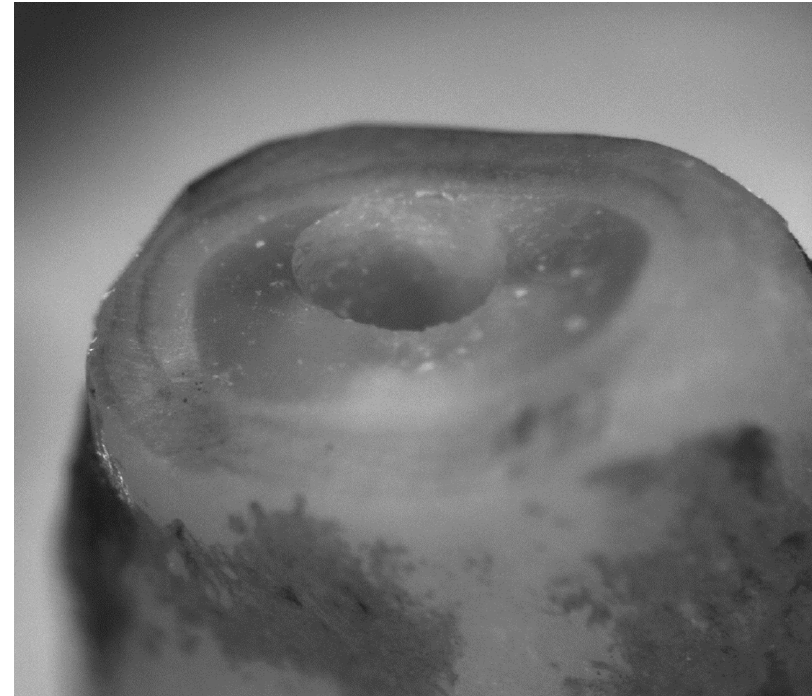
Figure 2. Details of the preparation.